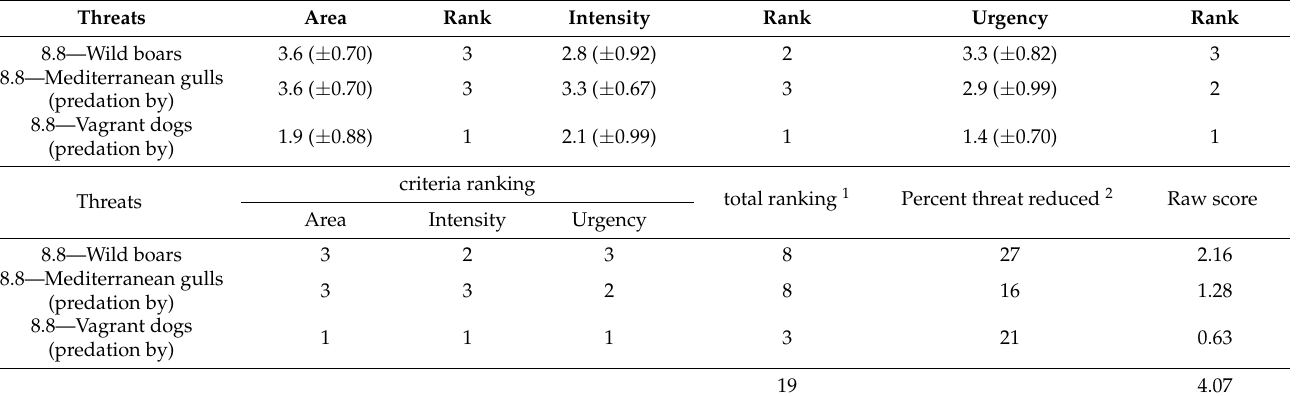
Table 3. Attributes of area, intensity and urgency and related ranks for the Threat Reduction Assessment (TRA) and procedure to calculate the TRA-I index, considering only the three threats directly involved in the project. (1): sum of ranking of area, intensity and urgency. (2): estimated percentage of threat mitigation over the assessment